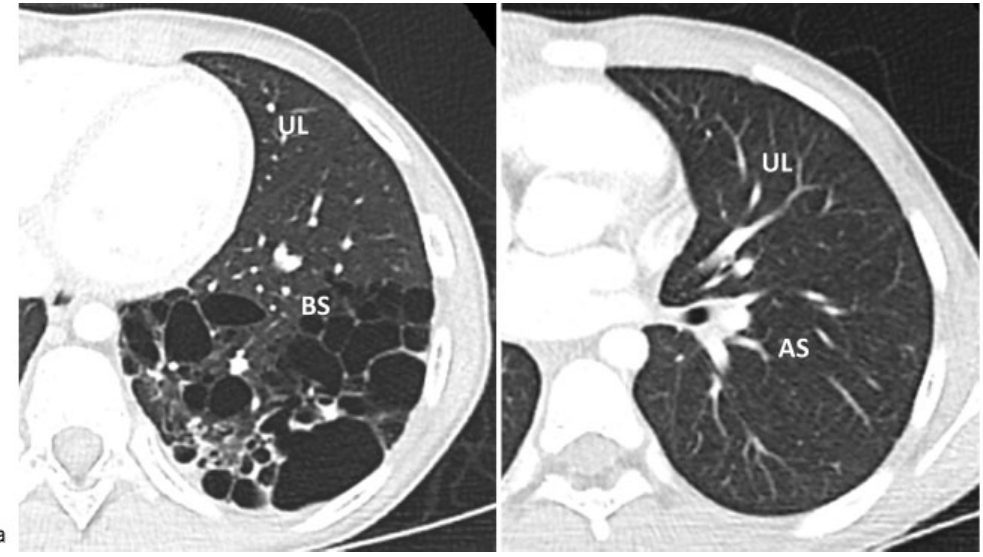
Fig. 2 Preoperative high-resolution computed tomography showing the affected BSwith a normal AS. ( a ) UL, BS. ( b ) UL, AS. AS, apical segment; BS, basal segment; UL, upper